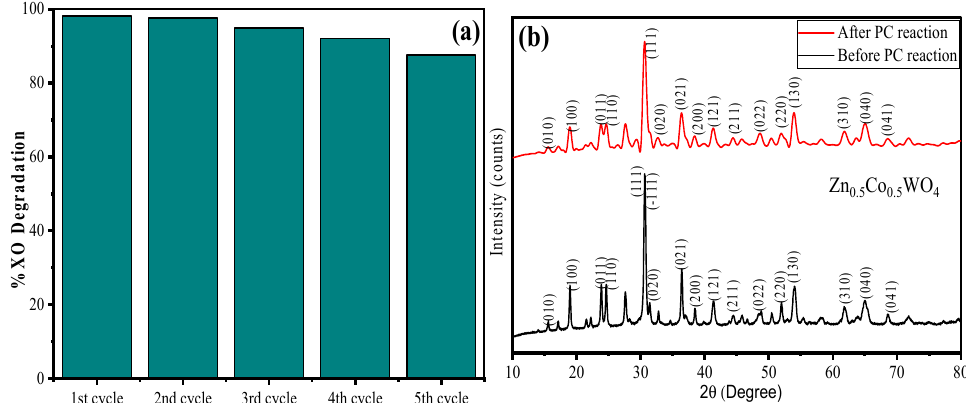
Figure 13. ( a ) Reusability test for synthesized Zn 0.5 Co 0.5 WO 4 NPs for XO degradation ( b ) XRD spectra of Zn 0.5 Co 0.5 WO 4 before and after the photocatalytic (PC) reaction.